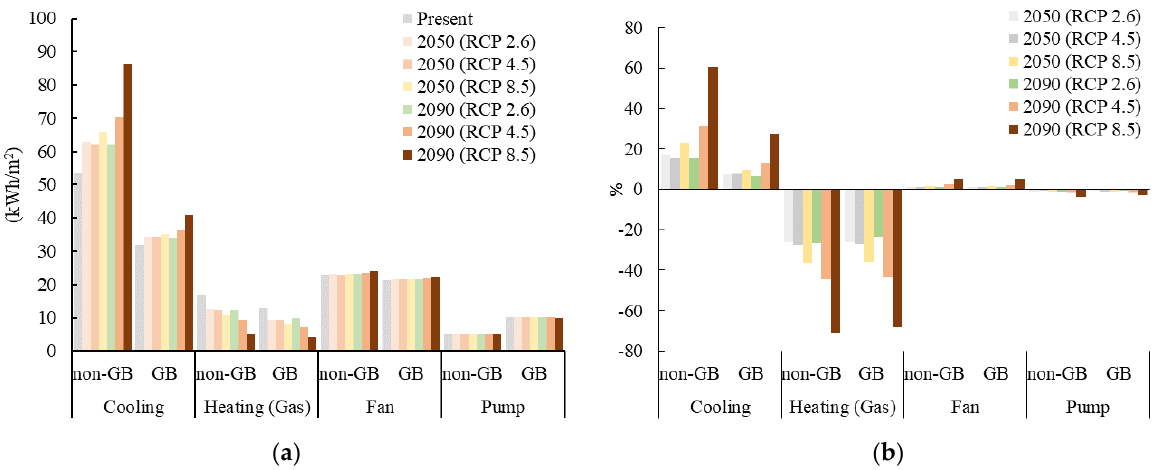
Figure 6. Simulation results expressed in ( a ) energy intensity (kWh/m 2 ); ( b ) percentage for the GB and non-GB.